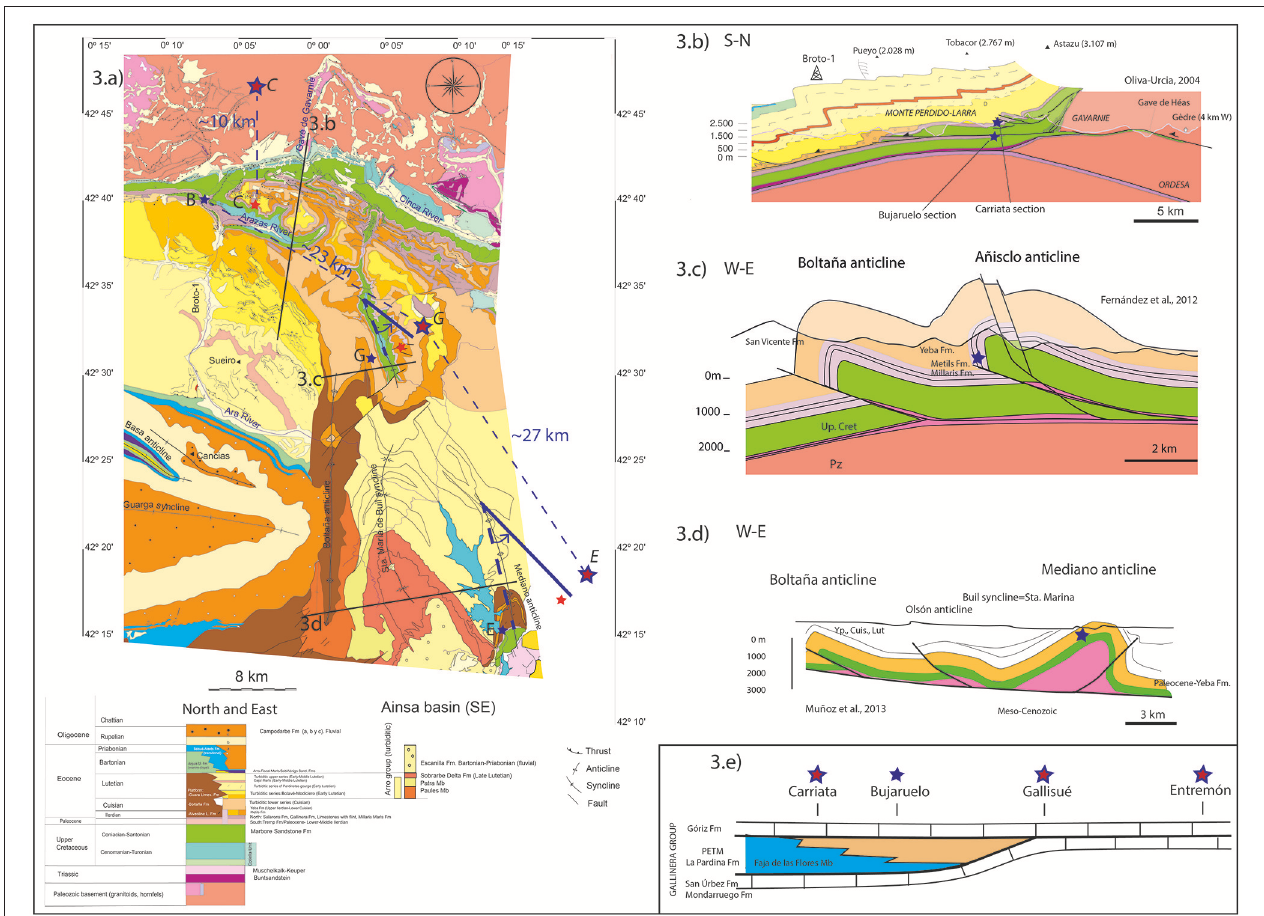
FIGURE 3 | Location of samples with more detail in (a) map view and cross-sections (b) , (c) and (d) . Shortening related to thrust and fold systems is ∼ 10km in the North, but < 2km for the E-W structures. Red stars locate the sections after restoration of the rotation (in case of the anticlines an anticlockwise rotation of 30 ◦ has been performed). Red stars with blue rim are locations of sections after individual rotation restoration and ∼ 3km of shortening restoration due to folding. The Bujaruelo section is the one with relative fixed position. C: Carriata, B: Bujaruelo, G: Gallisué, E: Entremón (in italics, the individually restored position of the sections). (e) Relative locations at the PETM time, adapted after Pujalte et al. (2016) and Robador et al. (2009) (in blue: prodelta sediments, in yellow: deltaic front).